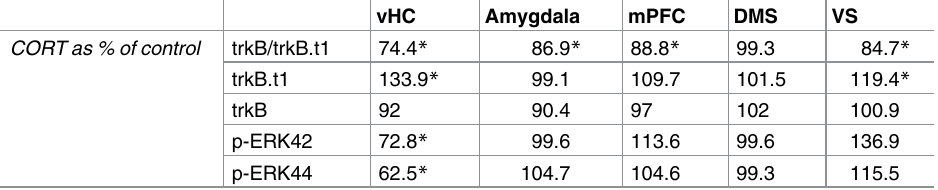
DMS, dorsomedial striatum; VS, ventral